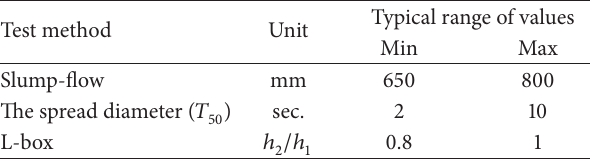
Table 4: Typical acceptance criteria for SCC [16].